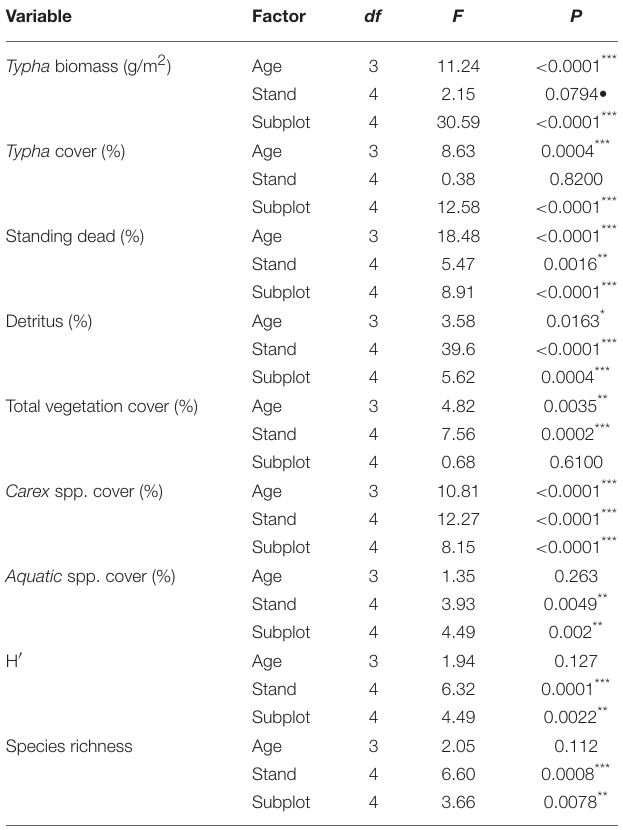
TABLE 2 | Results of statistical tests (ANOVA) evaluating the independent effects of age, stand, and subplot (proximity to stand center) on plant and environmental conditions in 2015, prior to treatment implementation.